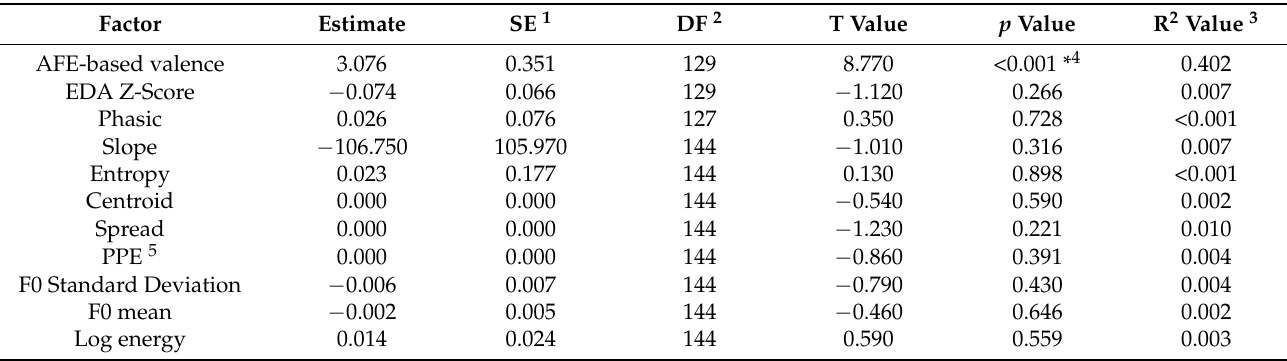
Table 5. Regression results of Valence dimension.